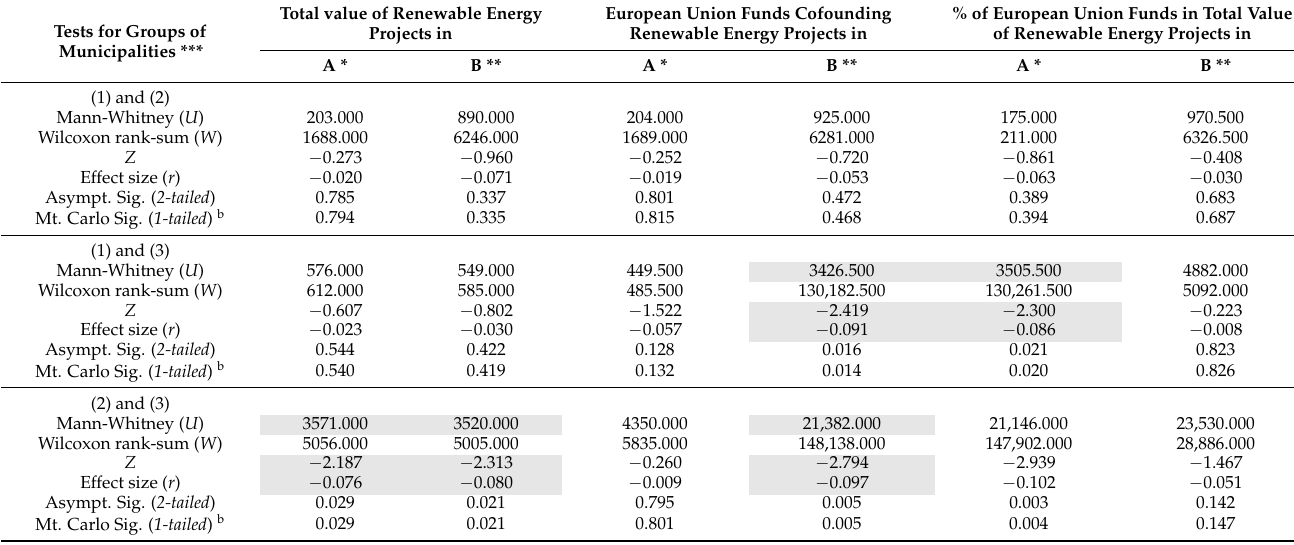
Table 6. Mann-Whitney U test for analyzed variables.